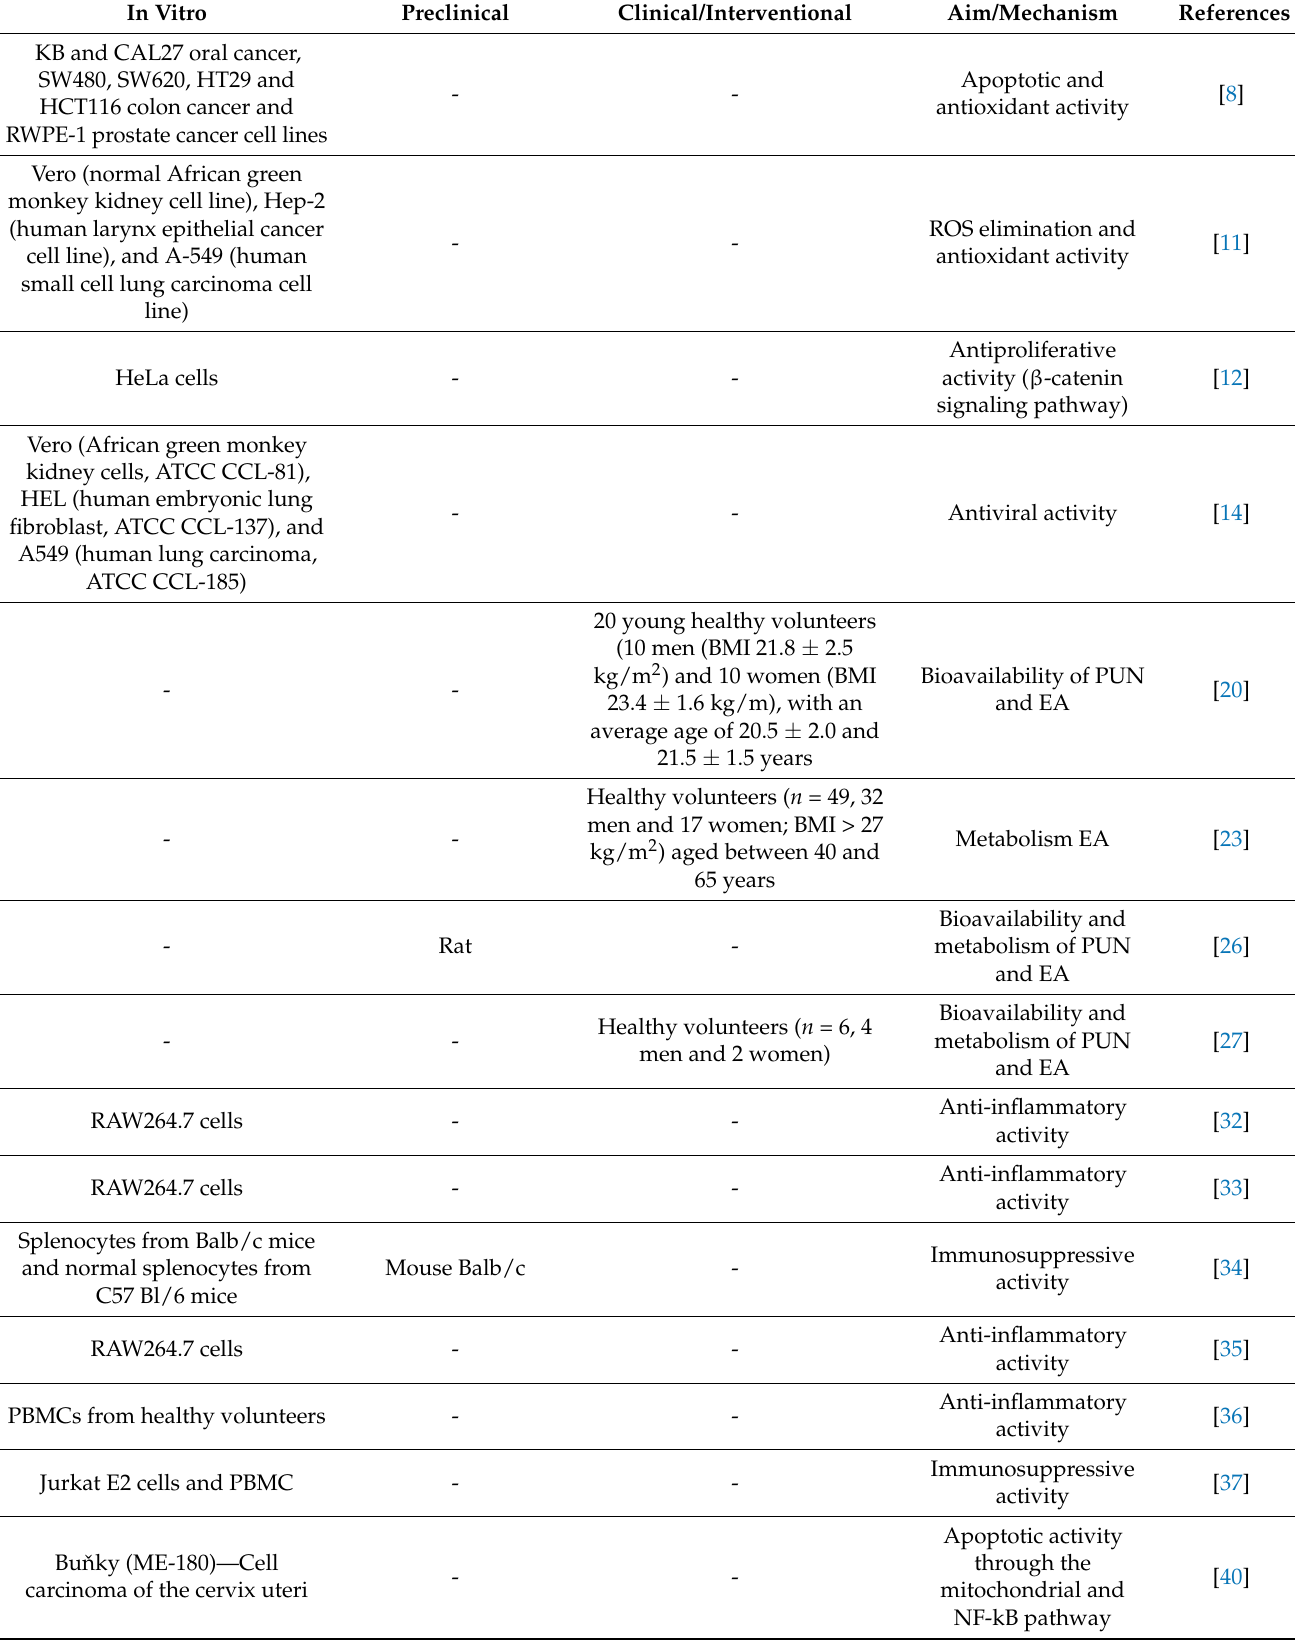
Table 1. Summary of the in vitro, preclinical and interventional studies involving punicalagin research. In